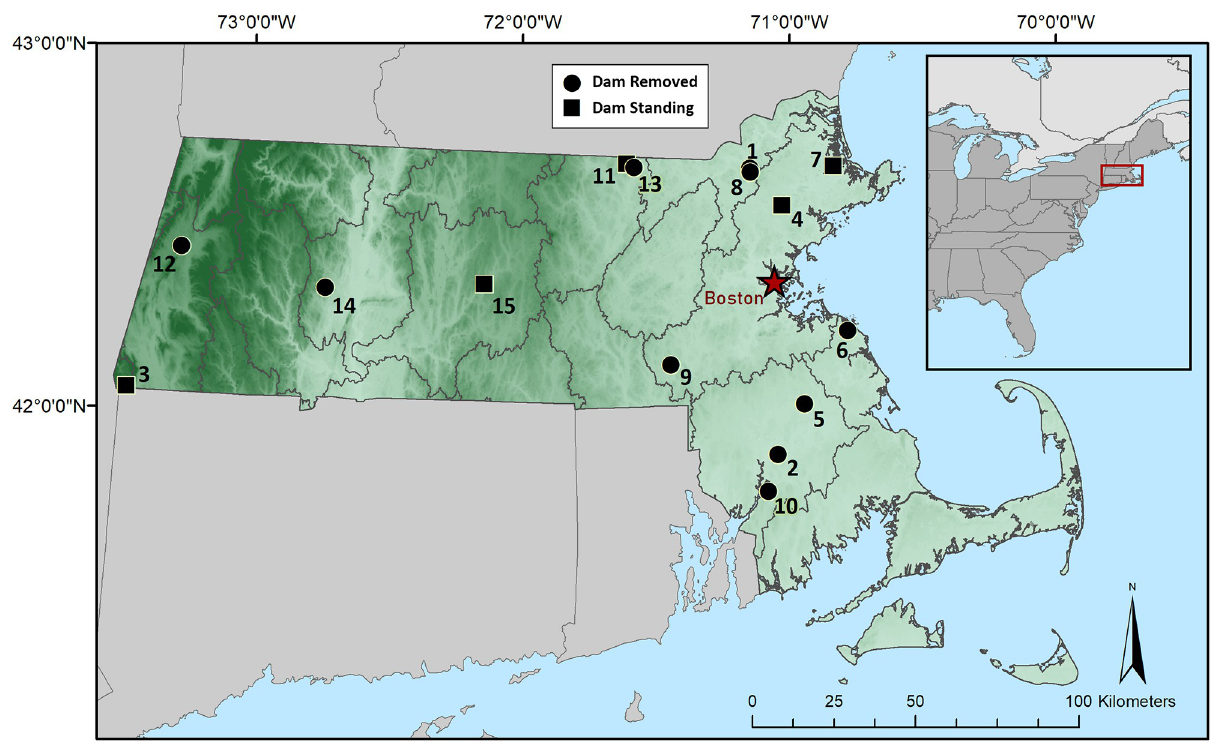
Fig 1. Study sites. Map of the 15 dams in Massachusetts, USA, monitored within this study, of which 10 (circles) were removed over the course of this study and 5 (squares) remained standing. See Table 1 for site information corresponding to numbers. Map was prepared using ArcGIS 10.8 (Esri, Redlands, California,